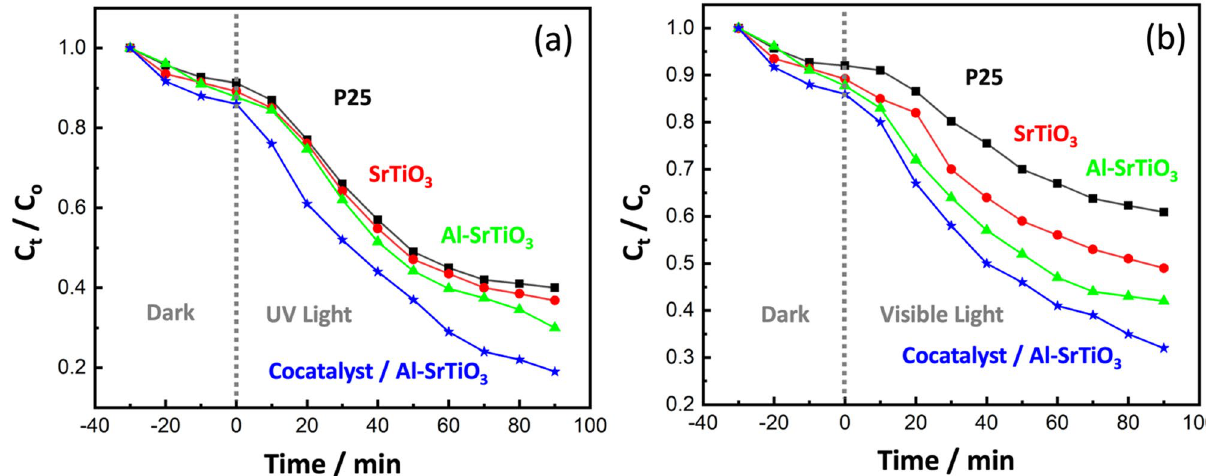
Figure 7. Time-dependent degradation of CR dye in the presence of P25, SrTiO 3 , Al-SrTiO 3 , and cocatalyst loaded Al-SrTiO 3 catalysts in dark and under ( a ) UV irradiation and ( b ) visible